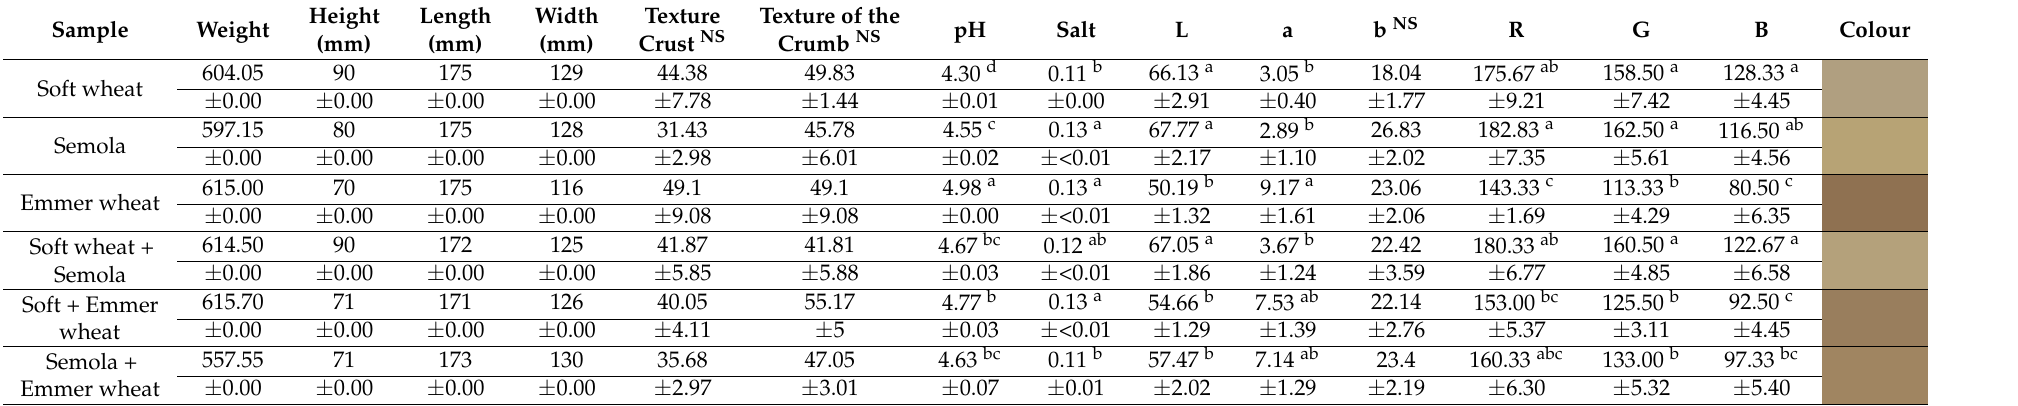
Table 3. Mean values ± standard error of the physicochemical data of each sourdough bread